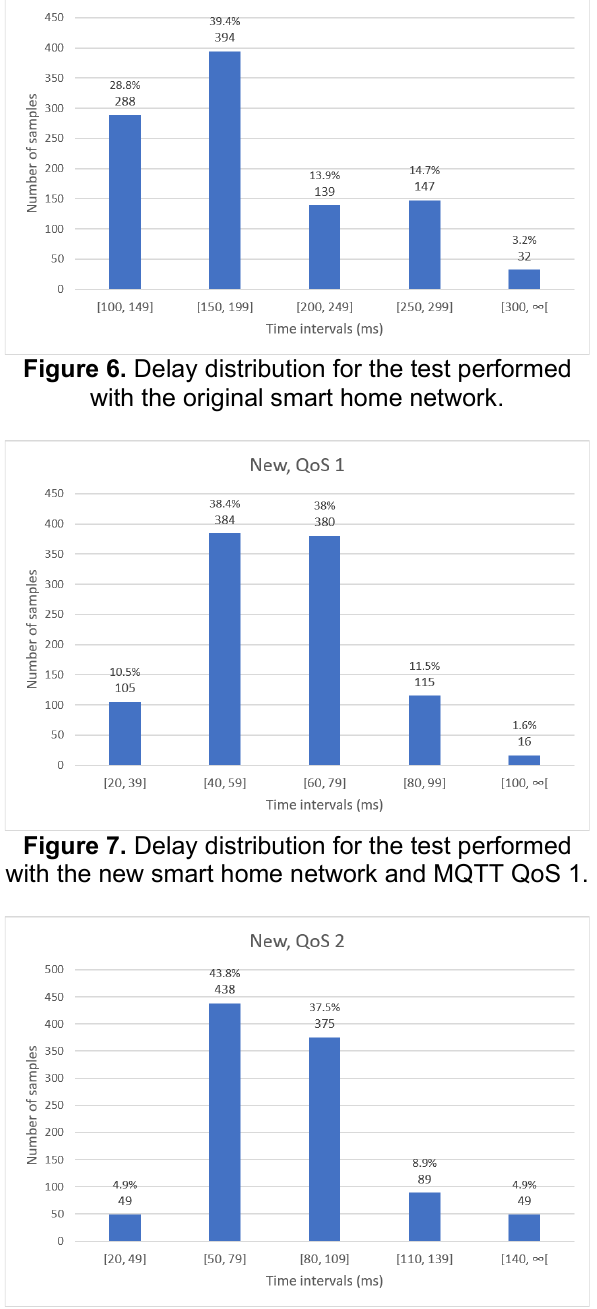
The maximum delay values observed, in all cases (563 ms for the original network, 203 ms with QoS 1,